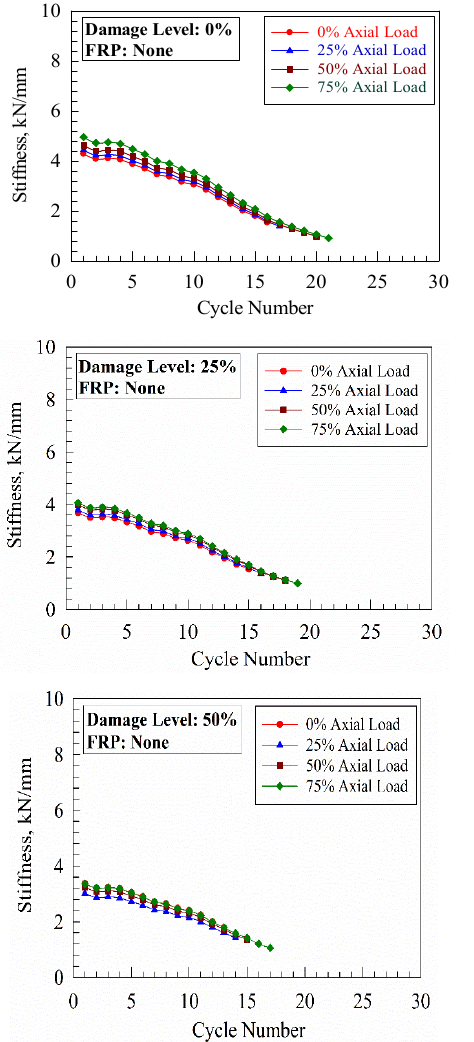
where E i denotes the energy dissipated, F mi is the load value, and D mi is the peak displace- ments for each loading cycle i